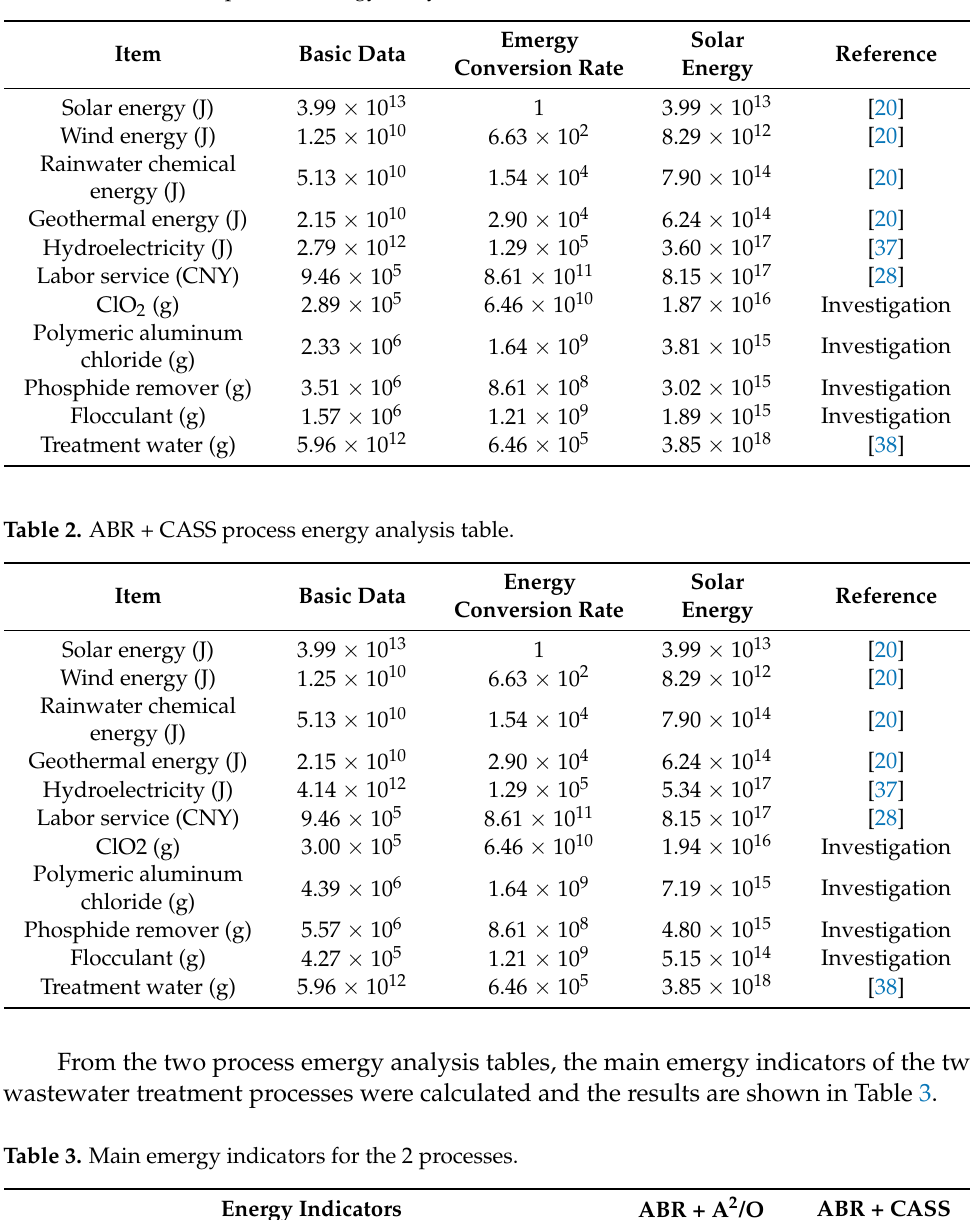
Table 1. ABR + A2/O process emergy analysis table.